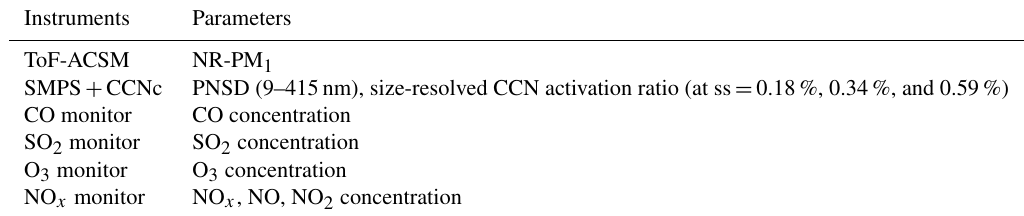
Table 1. Summary of the instruments used in the